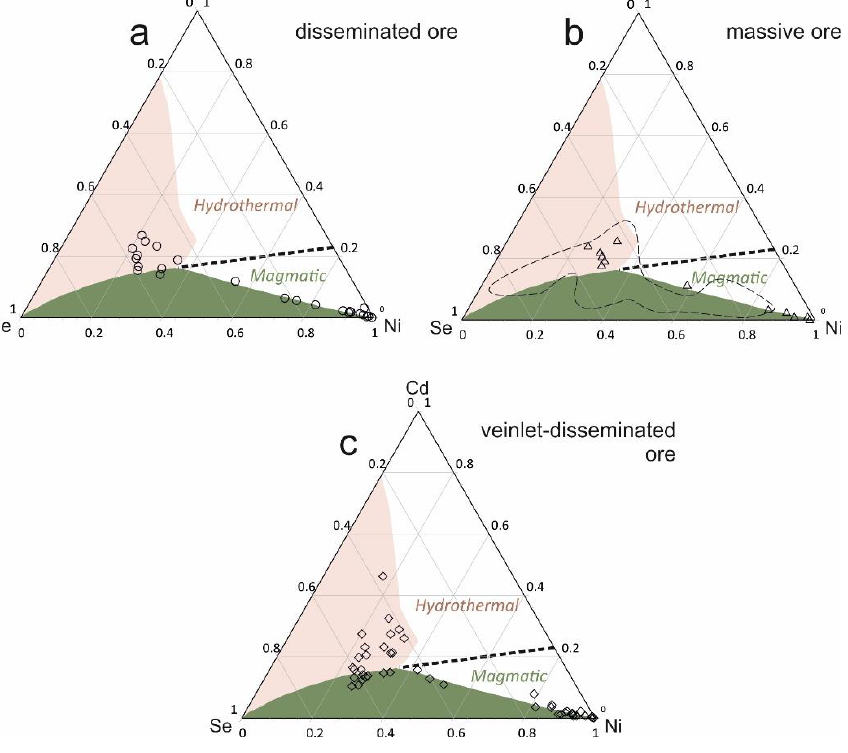
Figure 11. Ternary classification diagram based on concentrations of Cd, Se and Ni, according to the authors of [13]. The major idea of this classification is that the apexes trending to Ni and Cd are characteristics of magmatic and hydrothermal deposits, respectively. The apex trending towards Se was not given a genetic explanation by Duran et al. [13]. The thin dotted line is for the composition of chalcopyrite from massive ore of the Oktyabrsk deposit according to [16]. The bold dotted line discriminates hydrothermal and magmatic chalcopyrite according to [13]. Di ff erent symbols (circle, triangle and rhomb) are used for di ff erent ore types, respectively, disseminated, massive and veinlet-disseminated. ( a ) disseminated ore; ( b ) massive ore ( c ) veinlet-disseminated ore.